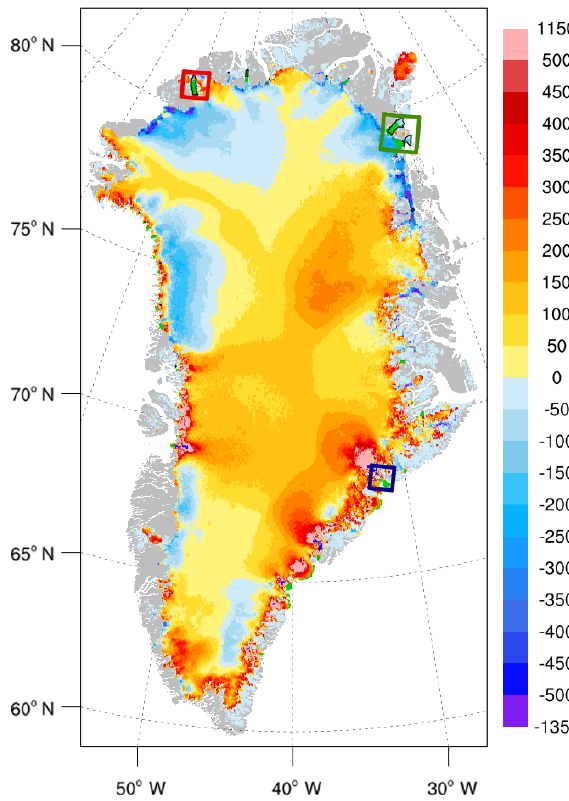
Figure 15. Difference (m) between (1) simulated ice thickness at the end of a 50kyr Greenland spin-up with ice shelves and (2) observed thickness from Morlighem et al. (2014). The observed thickness is the model initial condition. The thickness difference is shown for grounded ice only. Regions shaded light green are floating at the end of the simulation, and black contours enclose regions that are floating in observations. The three boxes indicate floating regions highlighted in Fig. 17: Petermann Glacier (red), 79 North Glacier and Zachariae Isstrom (dark green), and Kangerlus- suaq Glacier (dark blue). The gray background shows regions that are ice-free at both the beginning and end of the simulation.